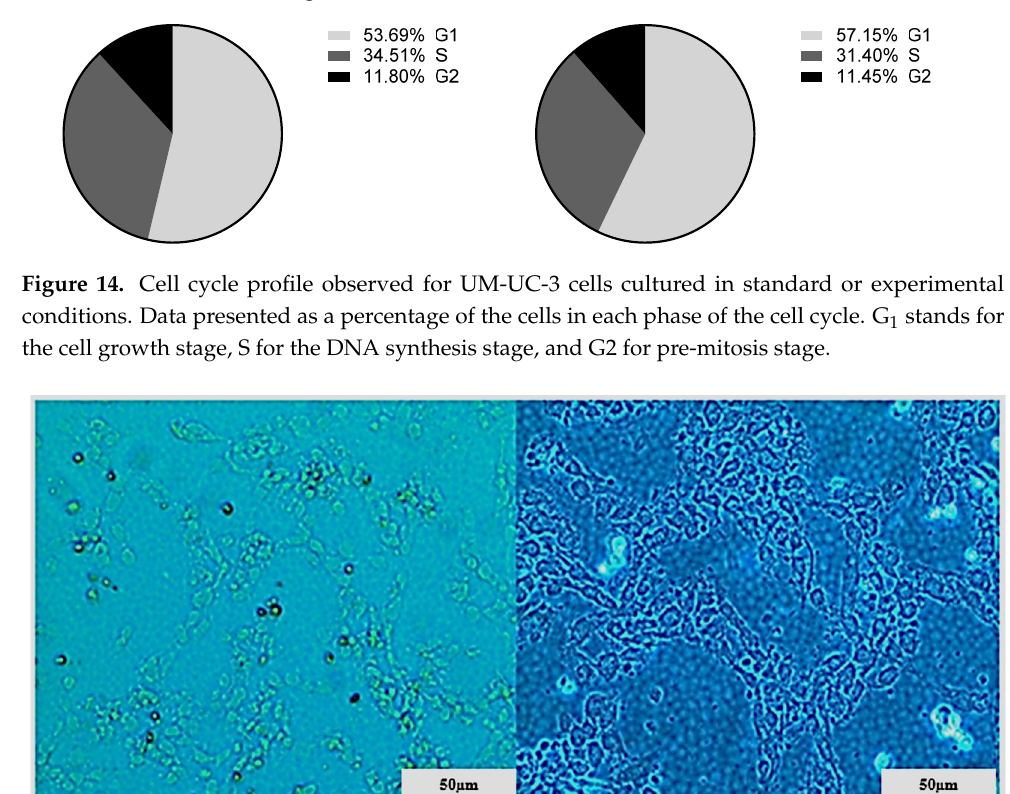
Figure 15. Representative images (Day 5) showing UM-UC-3 cells morphology cultured on LOC platform using peristaltic pump-driven medium exchange.